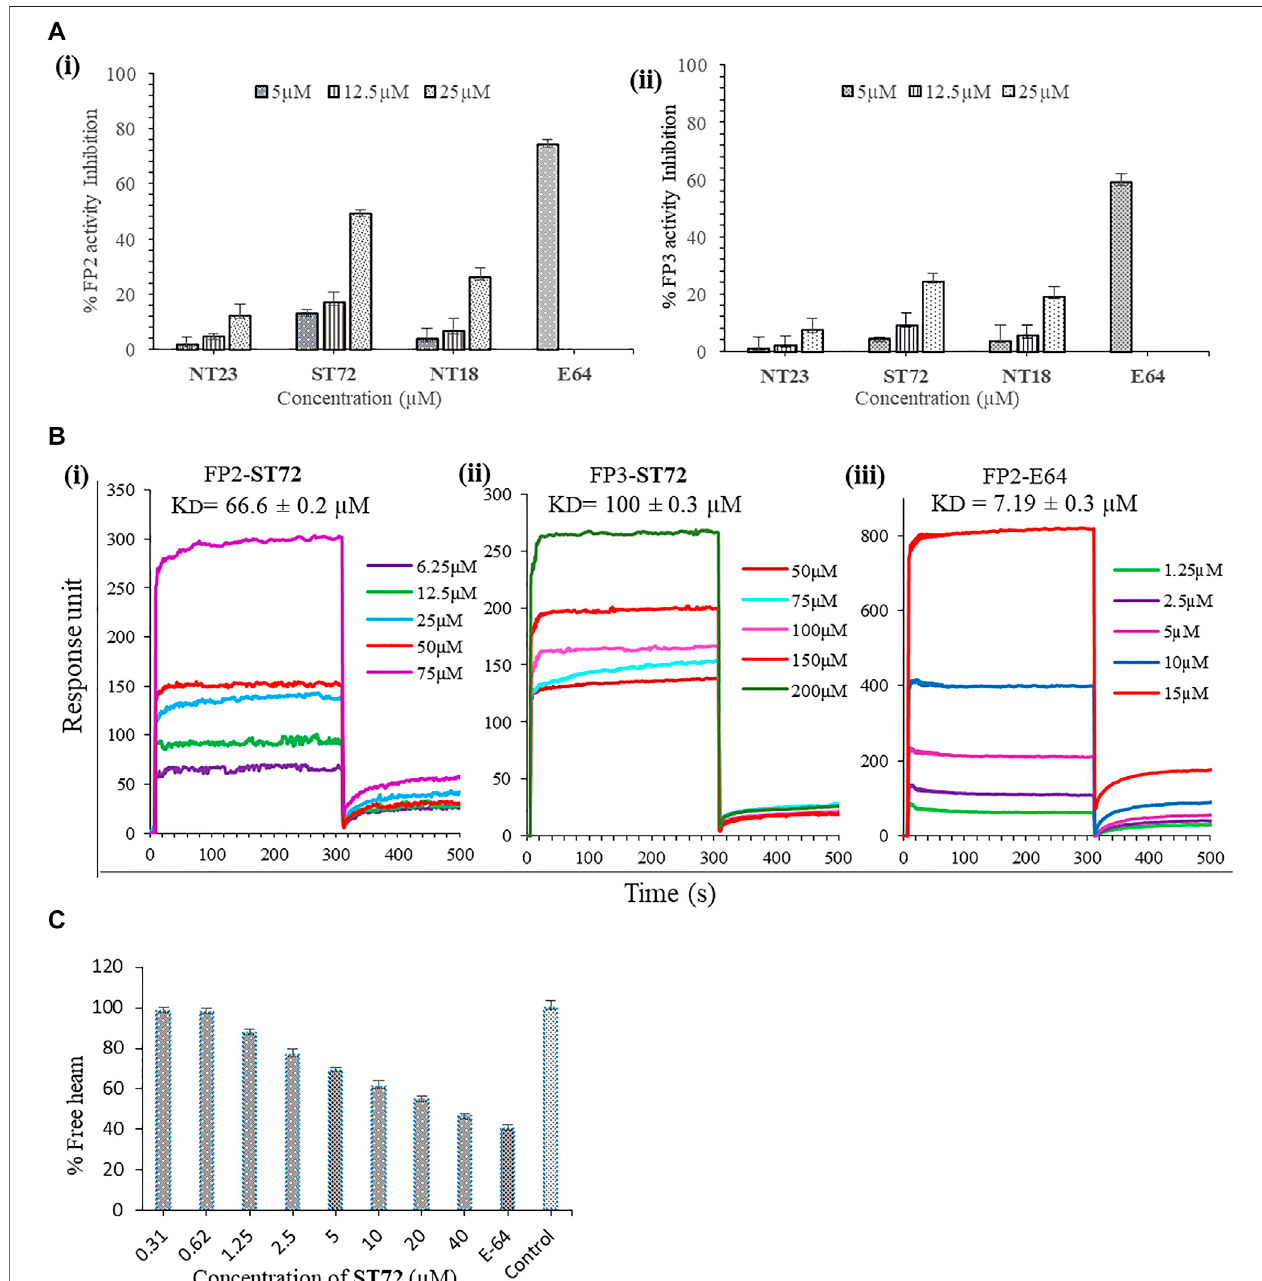
FIGURE 2 | (A) The bar graph represents enzyme inhibition activity of NT23, ST72, and NT18 for (i) FP2 and (ii) FP3. Hydrolysis of substrate Z-Phe-Arg-AMC was calculated. The graph shows increased percentage inhibition of FP2, indicating attenuation of hydrolysis of substrate peptides was calculated by fl uorescence intensity. Data were expressed as mean values ± SD. The experiments were carried out in duplicate. (B) Concentration-dependent real-time sensograms for SPR-based biomolecular interaction between FP2 (i) and FP3 (ii) with lead compound ST72. Recombinant proteins were immobilized on the surface of charged SPR chip. The experimentwasperformedwithincreasingconcentrationsofST72atassociationanddissociationtimeof300and150s.E-64(iii)wasusedasapositivecontrolshowing strong interaction with FP2. (C) Quanti fi cation of hemozoin inhibition by calculating percent free heme in ST72-treated parasite culture. Synchronized ring-stage parasites exposed to ST72 at different concentrations (0.31 – 40 µM) and percent free heme were estimated.